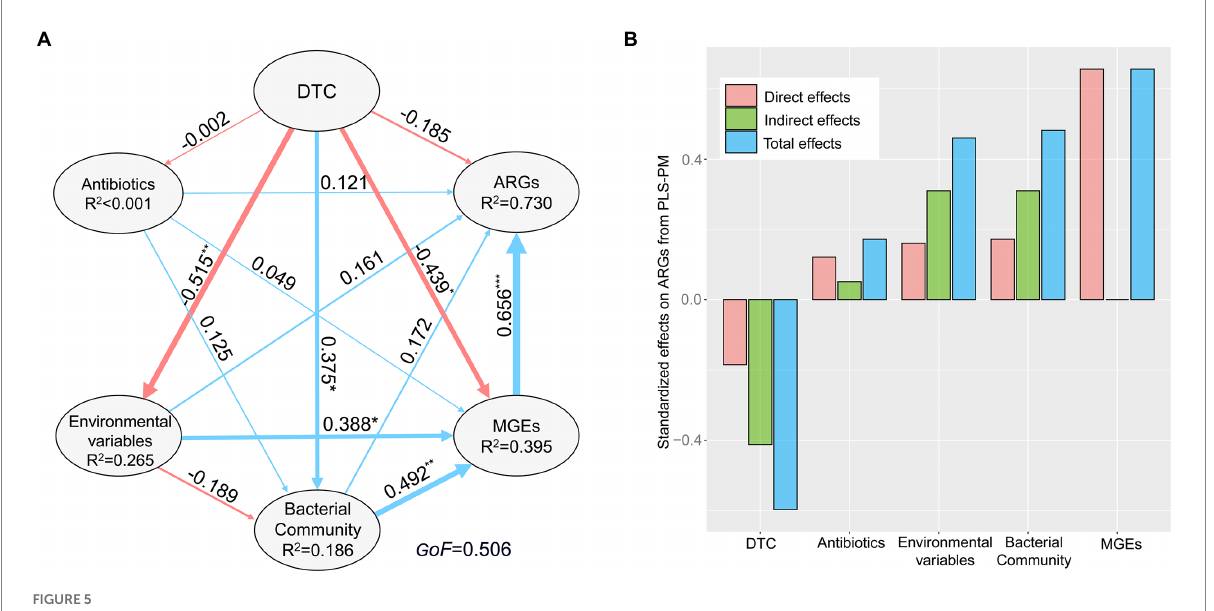
FIGURE 5 The direct and indirect effects of distance to coastline (DTC), antibiotics, environmental variables, bacterial community, and mobile genetic elements (MGEs) on sediment antibiotic resistomes across the study region. The final path of Partial Least Squares Path Modeling (PLS-PM) (A) . The blue and red lines indicate positive and negative direct effects, respectively. * p < 0.05, ** p < 0.01, *** p < 0.001. Data near each arrow is partial path coefficient ( λ ) associated with each relationship, and line thickness is proportional to the correlation coefficients. GoF , the goodness of fit index of the model. R 2 values represent the proportion of the variance explained for endogenous variable. (B) The bar plot showing standardized effects (direct, indirect, and total effect) derived from the